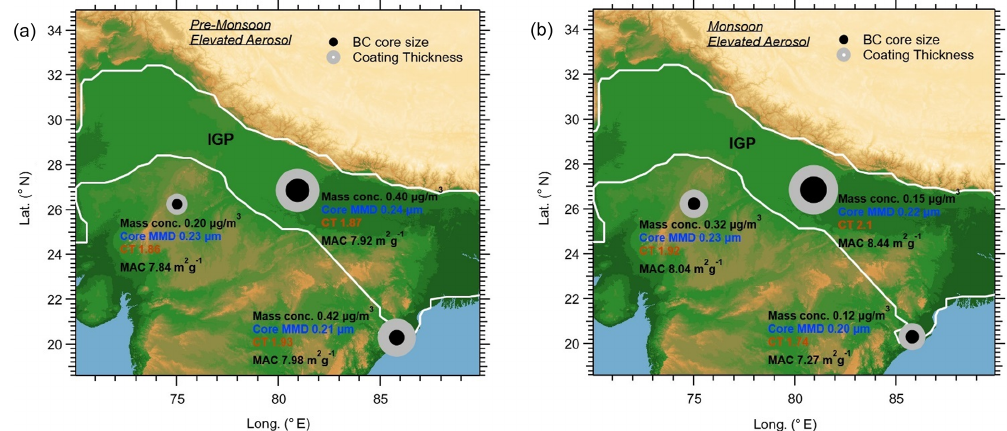
Figure 3. Pre-monsoon (a) and monsoon (b) average elevated aerosol above the boundary layer black carbon optical and physical properties, across northern India. The BC core and coating information is presented for NW India between Jaipur and Jodhpur, the central IGP, and NE India near Bhubaneswar. The IGP boundary (white line) is from Kumar et al. (2018). Map terrain created using Global multi-resolution terrain elevation data 010 (GMTED2010) (http://www.usgs.gov).